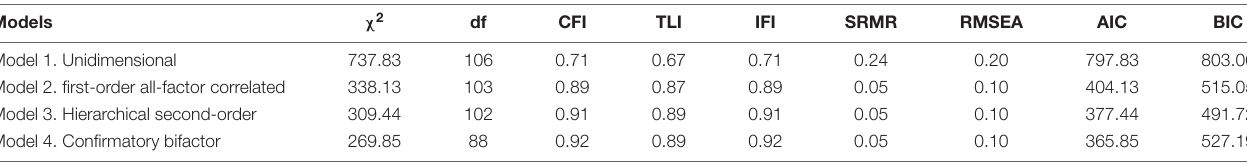
TABLE 2 | Fit indices of the models from confirmatory factor analysis. Models χ 2